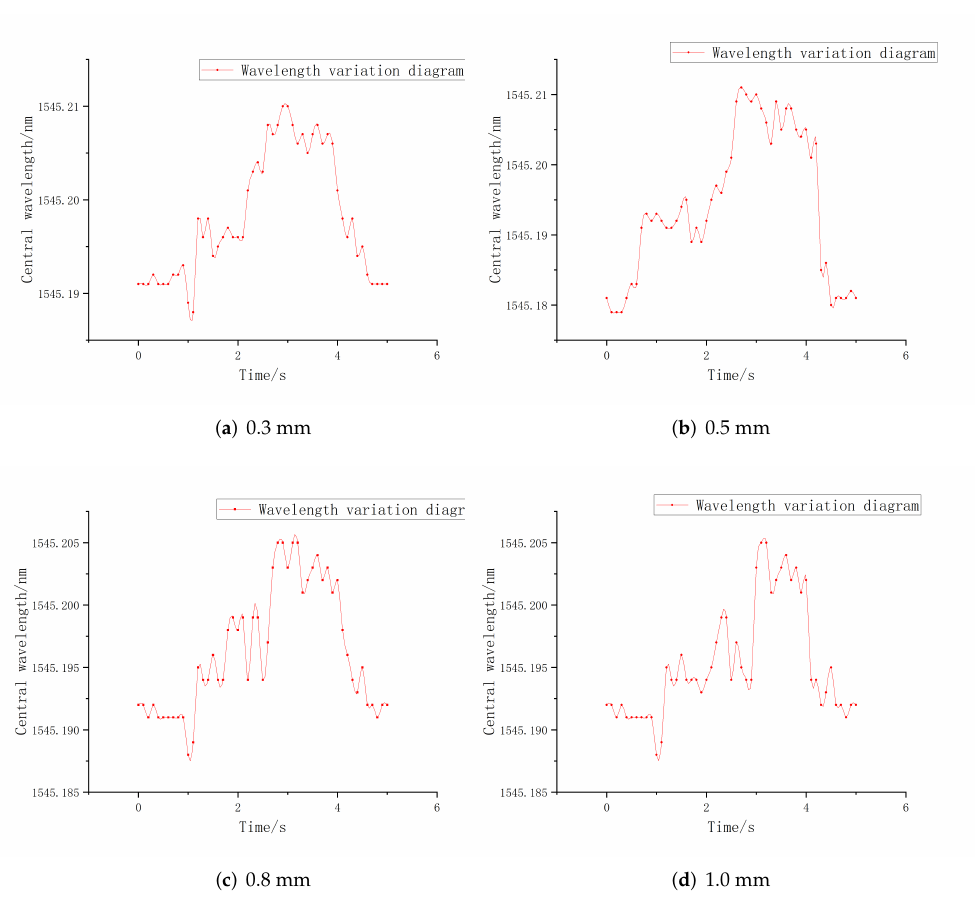
Figure 17. Wavelength-time diagram at different intervals.